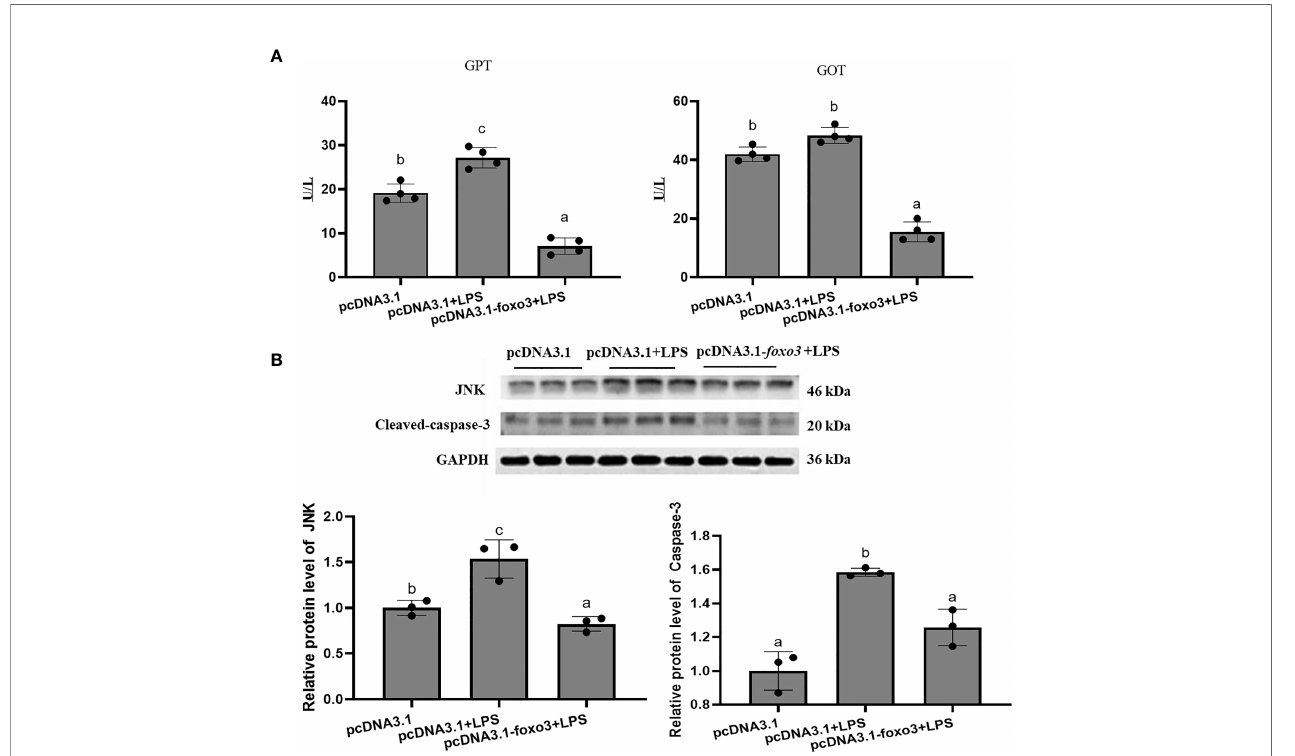
FIGURE 12 | (A) The levels of glutamate pyruvate transaminase (GPT) and glutamate oxaloacetate transaminase (GOT) in serum. Values are represented as the mean ± standard deviation (n = 4). Values with different letters mean signi fi cantly difference ( P < 0.05). (B) Protein levels in turbot liver. The relative protein abundances of JNK and cleaced-caspase-3 in turbot liver were measured by western blot and expressed as relative expression values to those in pcDNA3.1 group. Values are represented as the mean ± standard deviation (n = 3). Values with different letters mean signi fi cantly difference ( P <